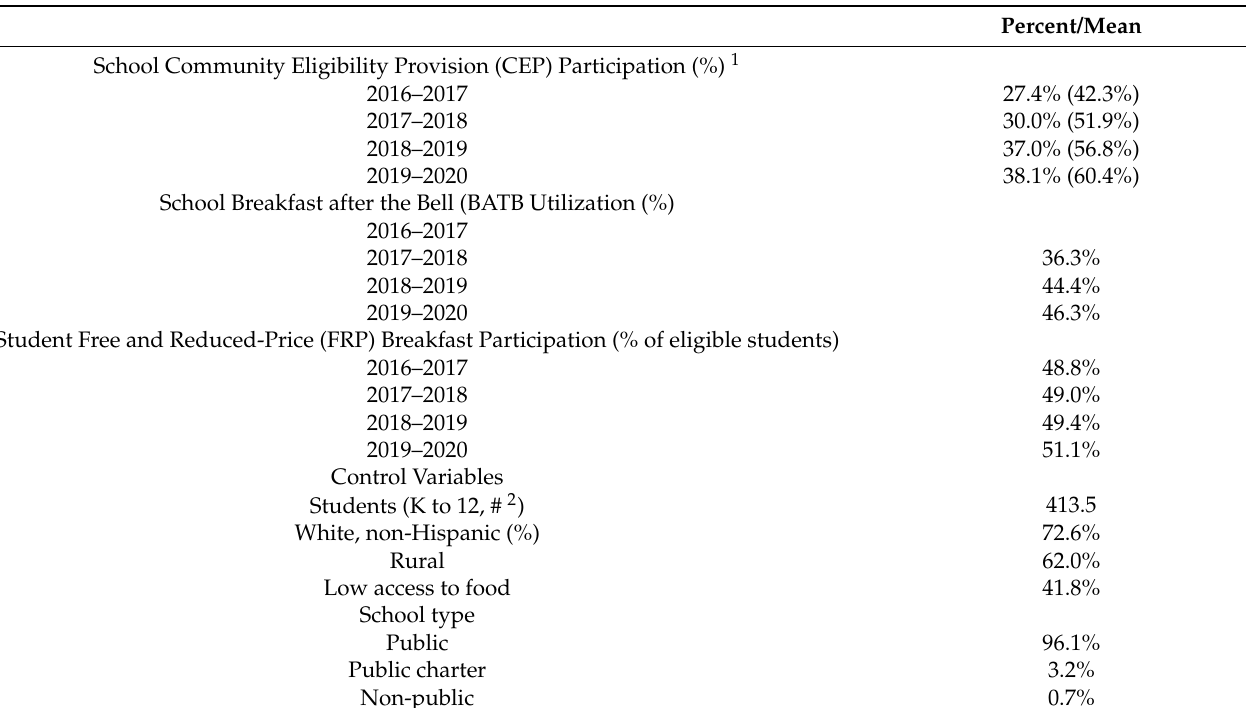
Table 1. Summary